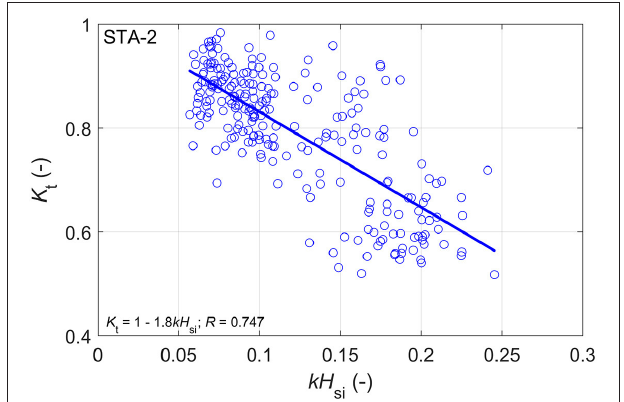
FIGURE 7 | The relationship between the wave transmission coefficient K t and the wave steepness kH si .